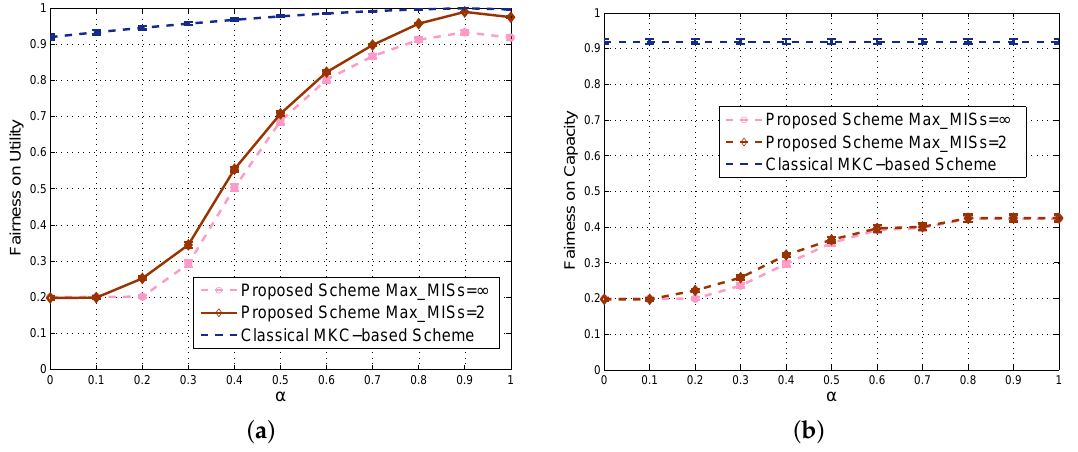
Figure 11. Comparison of fairness in dense scenarios: ( a ) based on utility; ( b ) based on capacity.